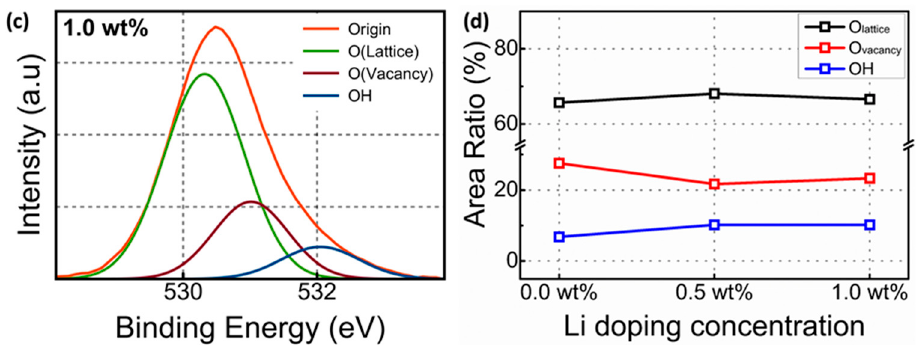
Figure 2. ( a – c ) O 1s XPS spectra and O 1s composition area ratio of Li-doped SnO 2 and ( d ) the variation of the composition ratio of O Vacancy , O Lattice , and –OH groups as a function of Li (wt%).